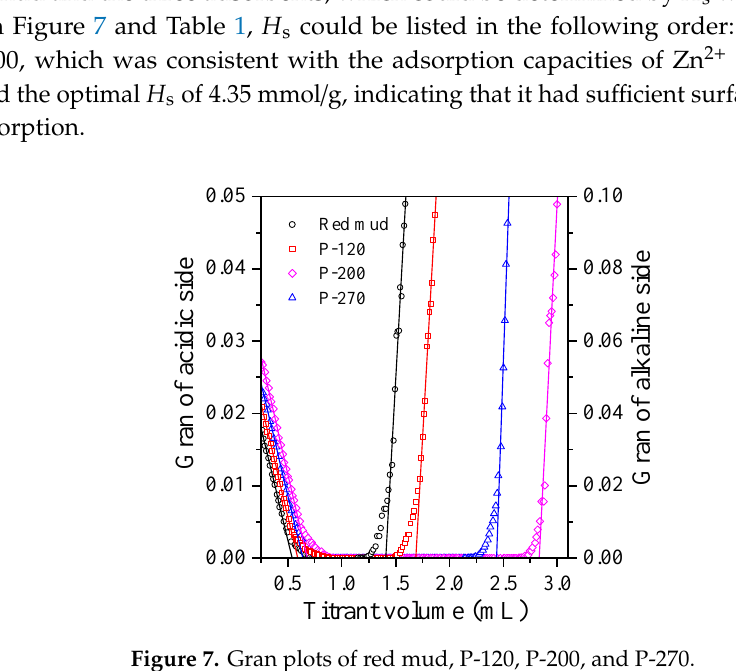
Figure 7. Gran plots of red mud, P-120, P-200, and P-270.